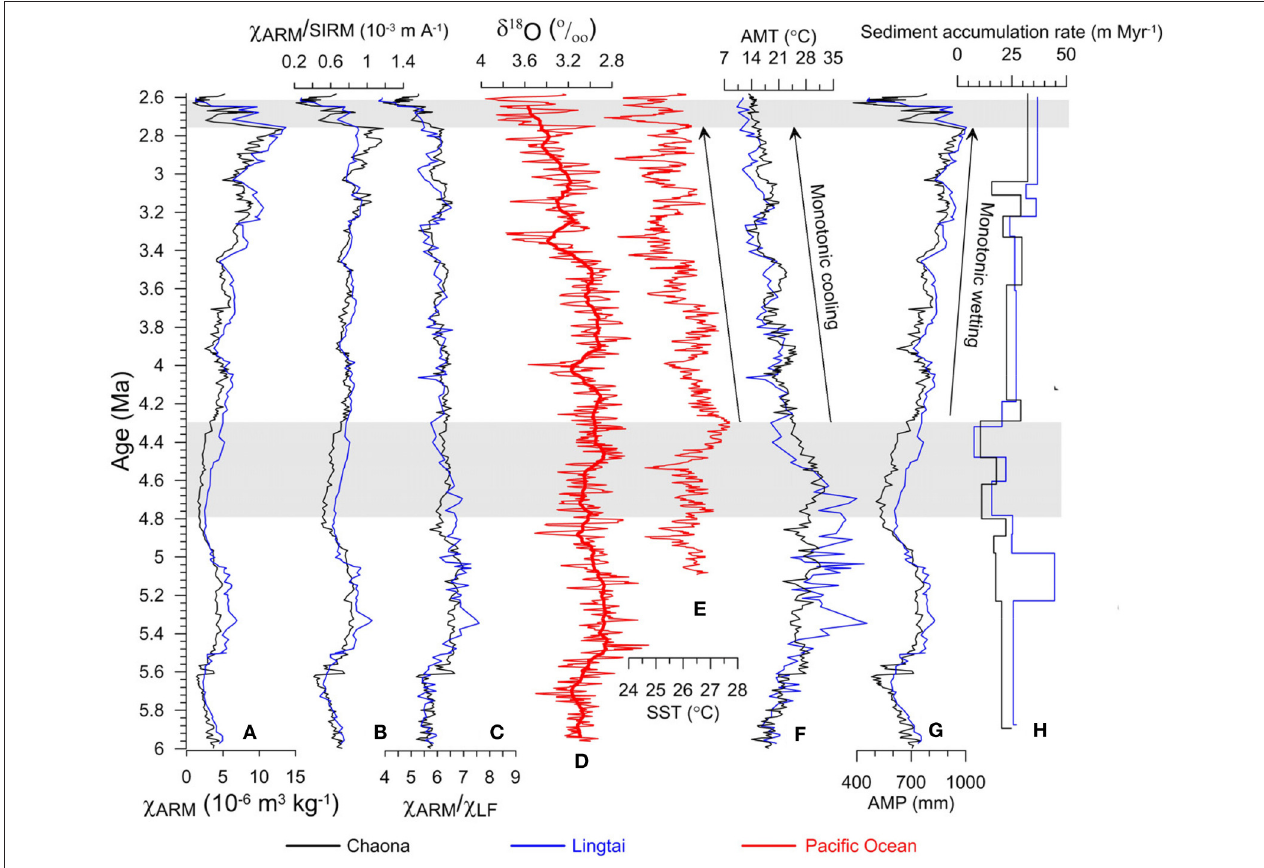
FIGURE 9 | Paleoclimatic and paleoceanographic data for the time interval 6–2.6 Ma. Modified from Nie et al. (2014b). (A–C) The Chaona (black) and Lingtai (blue) χ ARM , χ ARM /SIRM and χ ARM / χ LF records, respectively. (D,E) East Equatorial Pacific Ocean Drilling Project (ODP) site 846 benthic oxygen isotope ( Shackleton et al., 1995 ) and sea surface temperature (Lawrence et al., 2006) records respectively. (F,G) Reconstructed Chaona (black) and Lingtai (blue) annual mean temperature (AMT) and annual mean precipitation (AMP) records. (H) Chaona (black) and Lingtai (blue) sedimentation rate